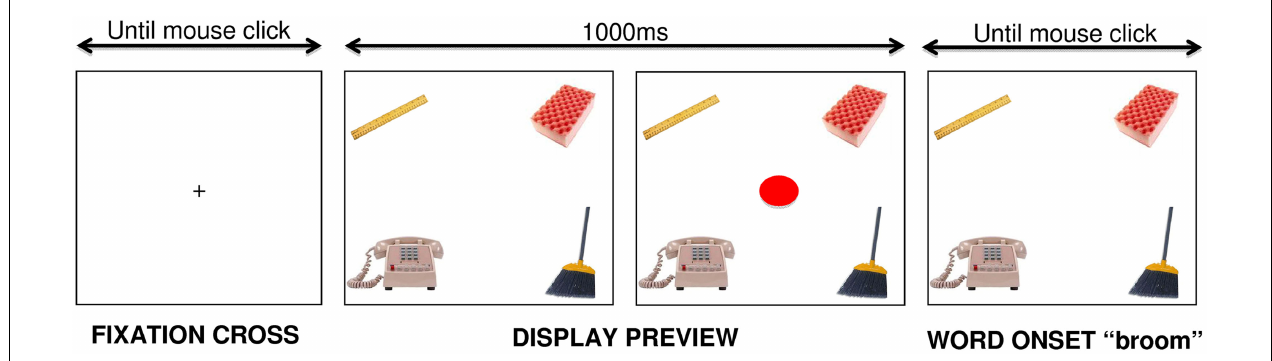
FIGURE 1 | Example of trial used in the eye-tracking experiment. The display presents the target object (e.g., broom), a semantic competitor (e.g., sponge), and two unrelated objects (e.g., phone and ruler).Target words were delivered after a 1000-ms preview of the